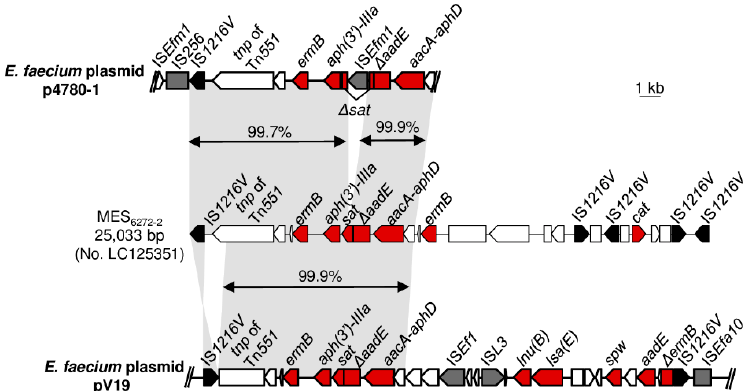
Figure 4. Genetic organization of MES 6272-2 -like structures in p4780-1 and pV19. The arrow indicates